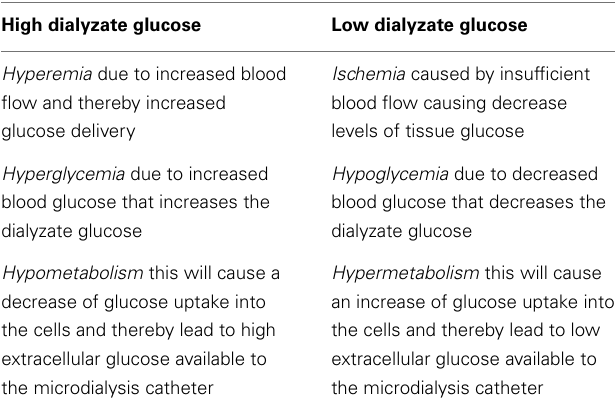
Table 1 |The table presents conditions that can lead to low or high dialyzate glucose